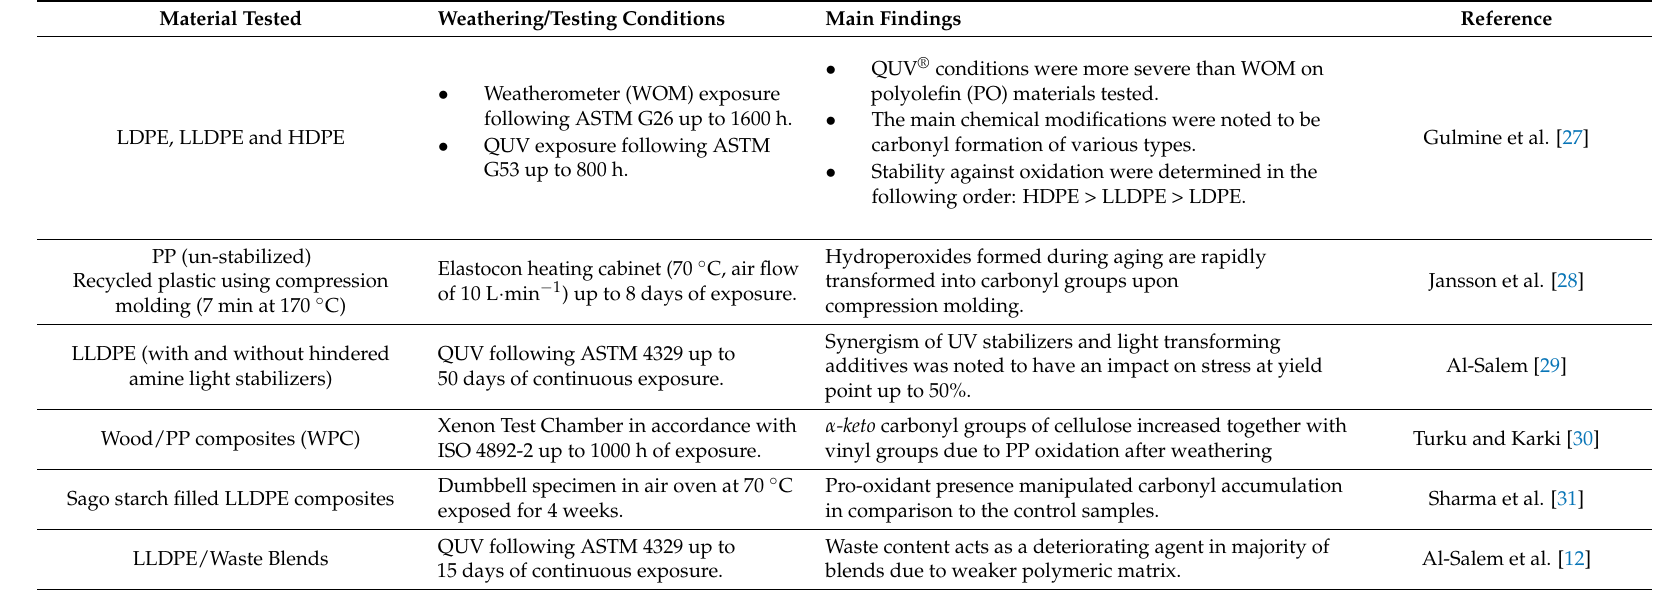
Table 1. Summary and Major Findings of Plastic Materials Weathering Studies Using the Means of Accelerated